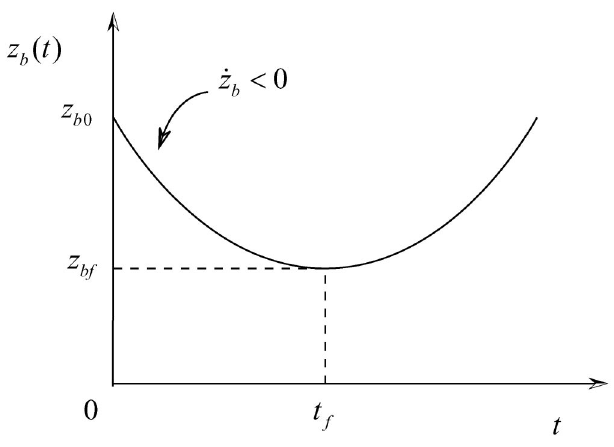
< 0 (cid:2) the rms b 0